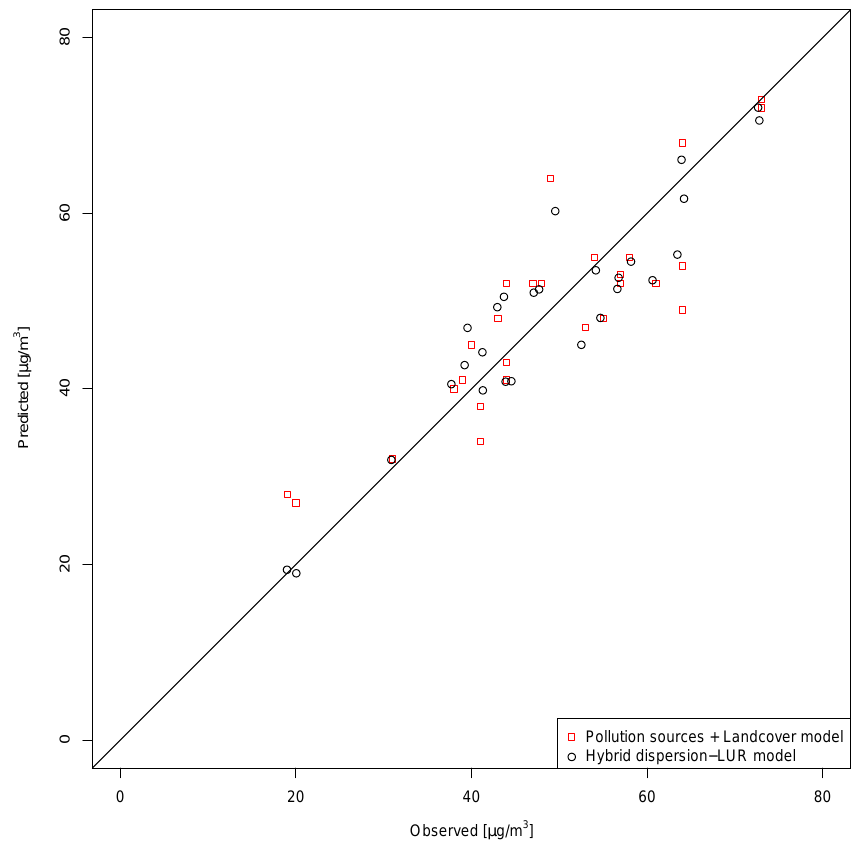
Figure 6. Observed to predicted comparison of